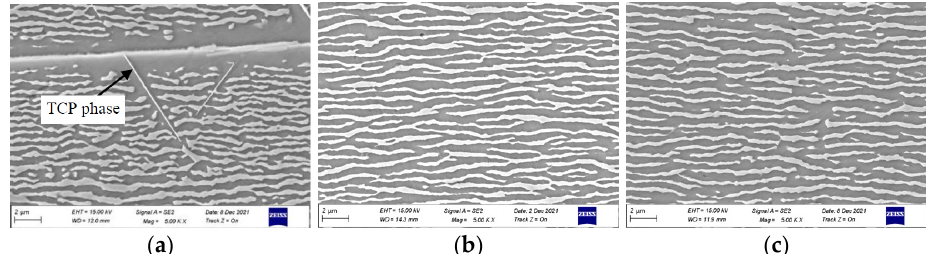
Figure 8. Microstructure 1.5 cm from the fracture surface of the ruptured samples at 1100 ° C/137 MPa (353.6 h): ( a ) 6% Co; ( b ) 9% Co and ( c ) 12% Co.